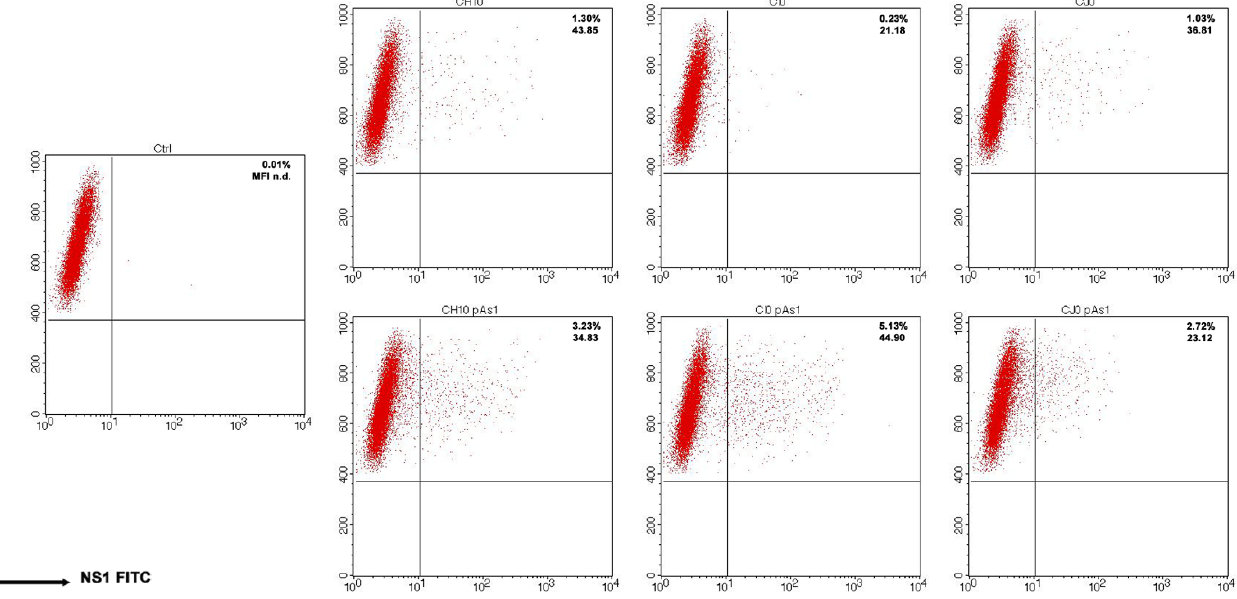
Figure 5. UT7/EpoS1 cells transfected with the indicated inserts (Ctrl, no DNA control) were sampled at 24 hpt, and cell population was analysed by cytofluorimeter to determine the percentage of NS1 expressing cells. Dot plot graph on gated cell population for FSc and NS1 FITC. Reported percentage values of positive cells and geometric mean fluorescence intensity (MFI) for positive subpopulations reported as the average result of two independent